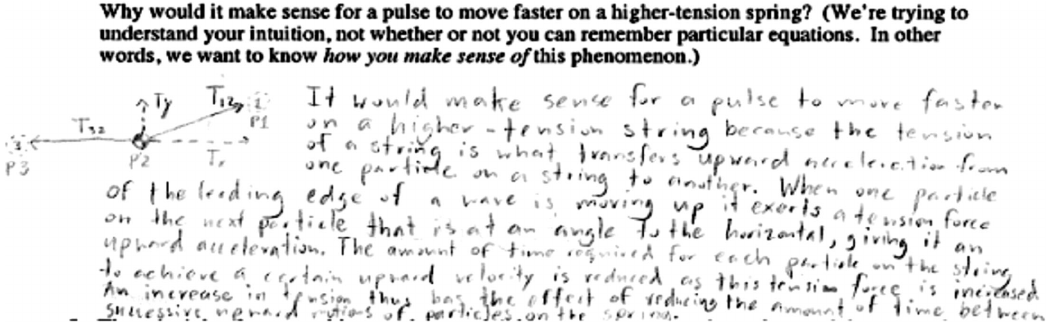
FIG. 2. Example student response to an explain-style question. “ It would make sense for a pulse to move faster on a higher-tension string because the tension of a string is what transfers upward acceleration from one particle on a string to another. When one particle of the leading edge of a wave is moving up it exerts a tension force on the next particle that is at an angle to the horizontal, giving it an upward acceleration. The amount of time required for each particle on the string to achieve a certain upward velocity is reduced as this tension force is increased. An increase in the tension thus has the effect of reducing the amount of time between successive upward motions of particles on the spring.